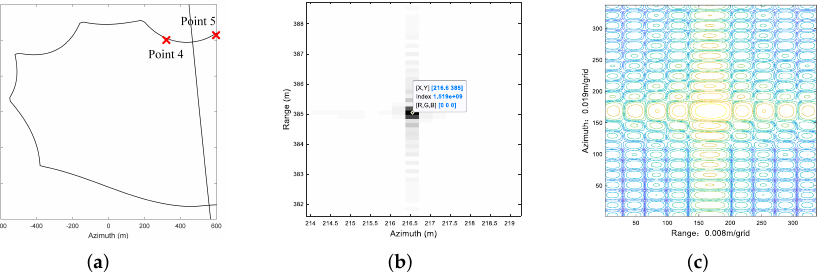
Figure 14. Analysis of the folding phenomenon.Two simulated targets are placed in ( a ) where the straight line is the borderline and the contour line is the swath limit for the signal model. Imaging results of Point 4 and Point 5 which prove the folding phenomenon with ( b ) the SAR imaging result of them and ( c ) the two-dimensional impulse response function of